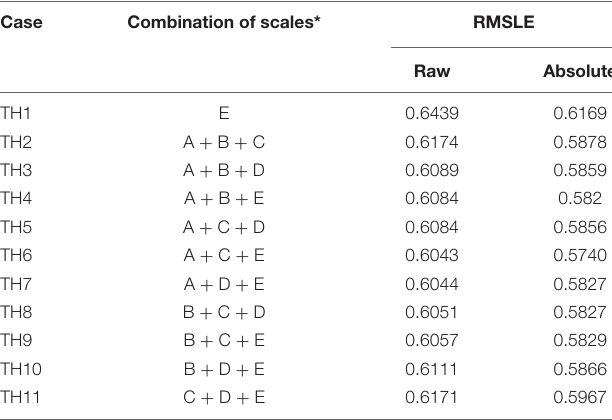
Frontiers in Earth Science |